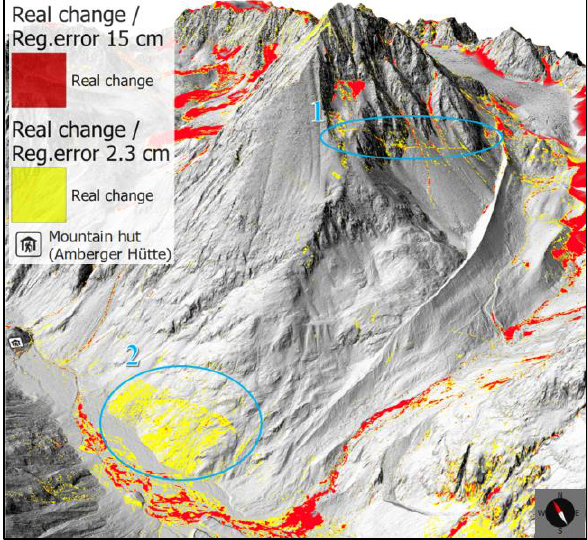
Figure 7 . Real changes with adjusted registration error of 15 cm (red) and real changes without registration error of 2.3 cm (yellow), blue ellipses indicate problematic areas with relatively Figure 5 . Histogram of the 3D distances of the additional stable low point cloud validation areas.